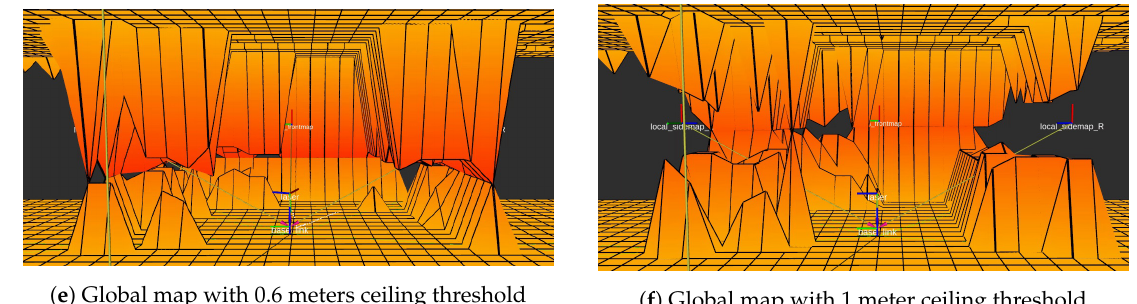
Figure 12. Results of the reconstruction experiment without using RGB